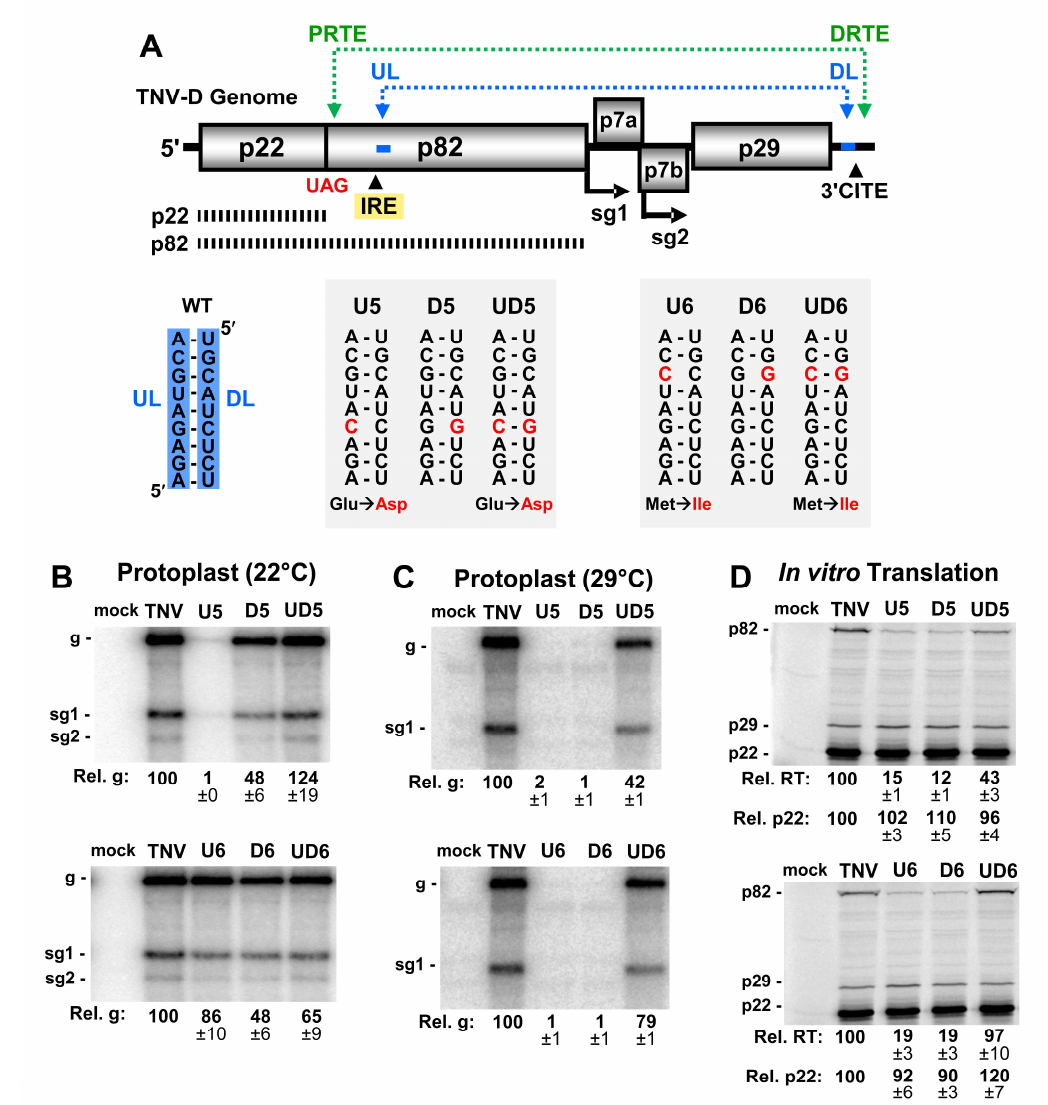
Figure 2. Analysis of the upstream linker (UL) and downstream linker (DL) interaction. ( A ) Cartoon representation of the TNV-D genome with the UL–DL interaction shown by a blue double-headed arrow. Wild-type nucleotide sequences of the UL–DL interaction are highlighted in blue, and nucleotide substitutions in mutants are shown in red, with corresponding amino acid changes below. ( B and C ) Northern blot analyses of TNV-D RNA accumulation in cucumber cotyledon protoplasts incubated for 22 h at either ( B ) 22 ◦ C or ( C ) 29 ◦ C. Above each lane is the name of the viral genome analyzed, with the positions of the viral genome (g) and subgenomic mRNAs (sg1 and sg2) denoted to the left of the blot. In this and subsequent experiments, the relative genome levels (Rel. g) of mutant genomes were determined by relative comparison to that of wt TNV-D (set at 100%) and are shown below each lane, as determined from three independent experiments ( ± standard error). ( D ) In vitro translation assay of TNV-D genomic RNA incubated in wheat germ extract. Viral constructs tested are noted above their respective lanes, and the identities of the protein products (p82, p29, and p22) are shown on the left. Relative readthrough (Rel. RT) was calculated as the ratio of p82 / p22, with that for the wild-type genome set as 100%. Relative p22 levels (Rel. p22) were determined by direct comparison of wt (100%) versus mutant levels. The corresponding means ( ± standard errors) were calculated based on three independent assays.